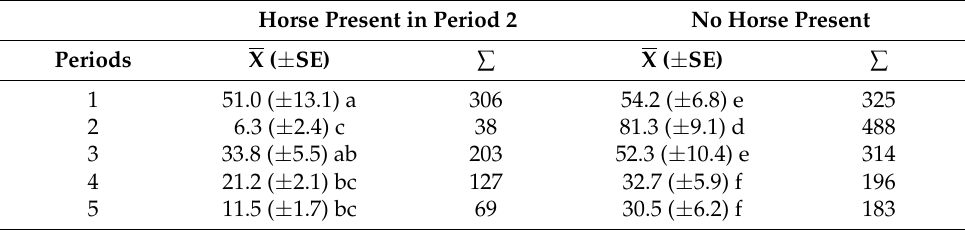
Table 1. Mean ( ± SE) and total numbers of mosquitoes captured per 20 min trapping period in the horse barn with a CDC 1012 trap from 19 July–21 August 2004 at the UF Horse Teaching Unit, Gainesville, FL, USA, showing the effect when a horse is placed in the stall adjacent to the trap during period 2 ( n = 6). Horse Present in Period 2 No Horse Present Periods X ( ± SE) ∑ X ( ±